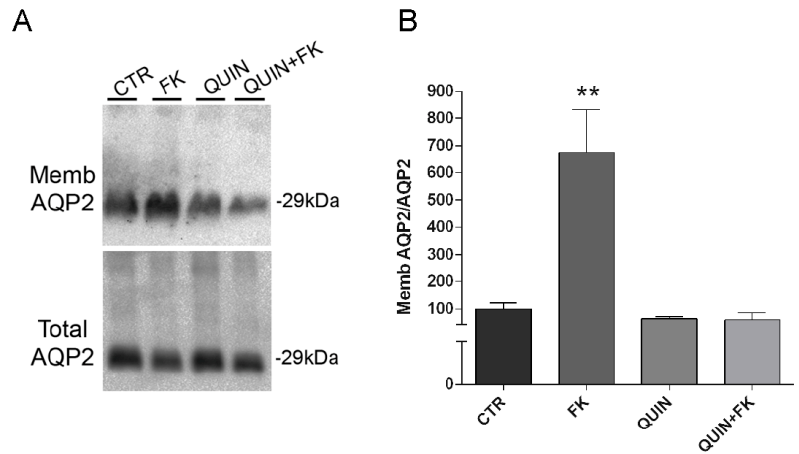
Figure 7. Cell surface biotinylation of AQP2 in MCD4 cells. ( A ) Immunoblotting analysis of total and apical AQP2 under different experimental conditions. Compared to untreated cells (CTR), FK significantly increased the abundance of AQP2 at the apical plasma membrane. Quinidine impaired FK-stimulated increase in cell surface expression of AQP2. Quinidine alone did not affect cell surface expression of AQP2. ( B ) Densitometric analysis of the 29 kDa biotinylated AQP2 band normalized to total AQP2 (values are reported as means S.E.Ms; ** p = 0.006 versus CTR).